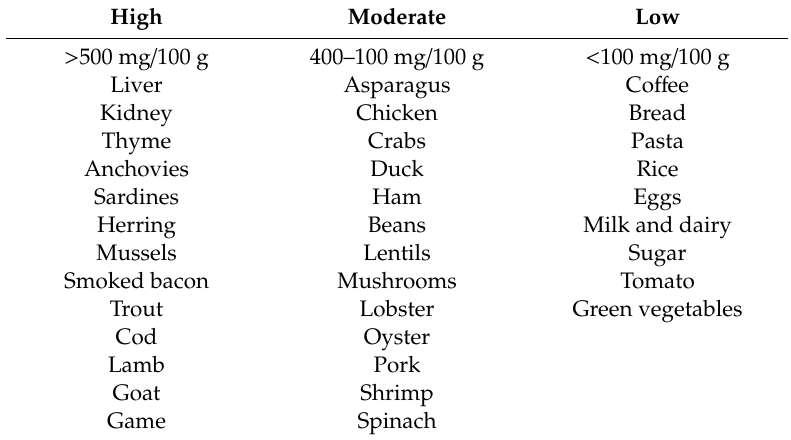
Table 3. Foods grouped in three categories by purines content per 100 g of edible